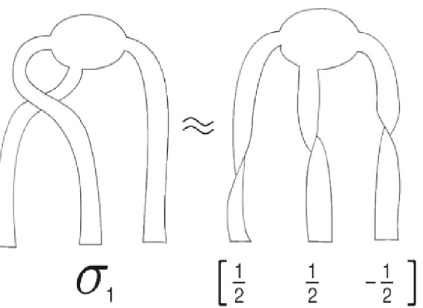
Fig. 2 One can go from the framed braid on the left (with braiding but no twisting) to the one on the right (with twisting but no braiding) by turning over the disk at the top by π around the axis that passes through its center and between the first and second ribbons. Source,